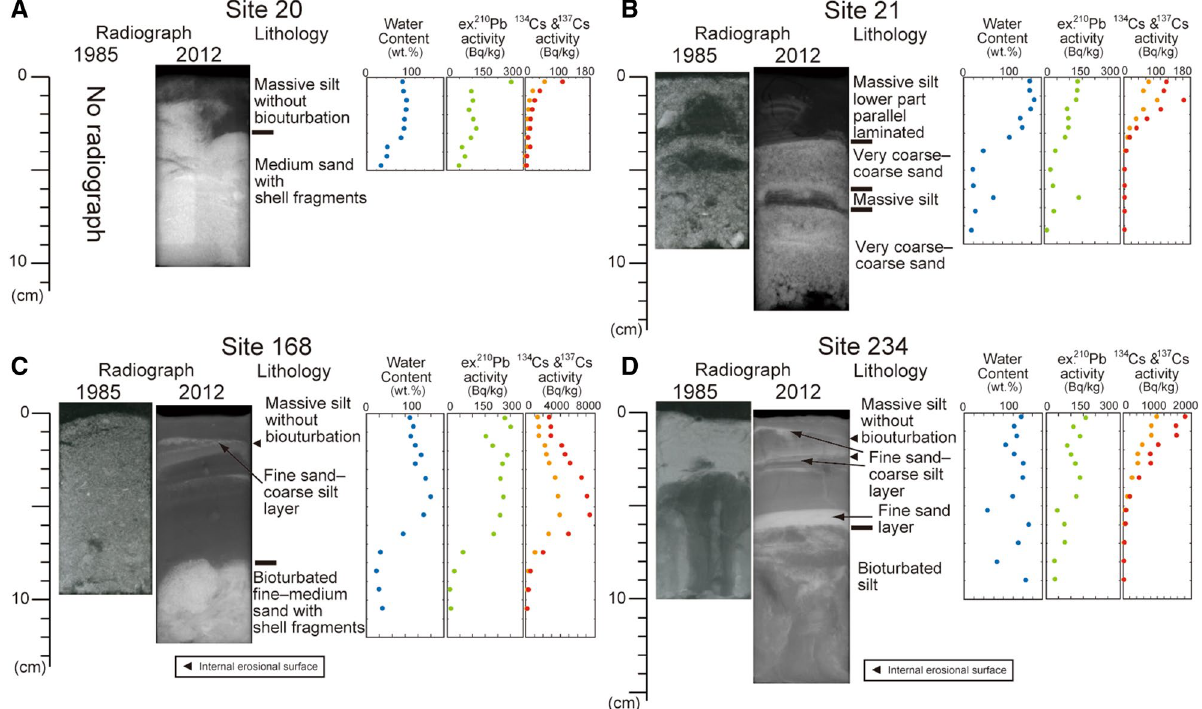
Figure 4. Comparison of sedimentary structures of the 1985 and 2012 sample, and description of 2012 subcore sample, and the profiles of water content (blue), excess 210 Pb (green), 134 Cs (orange), 137 Cs (red) activities at Sites 20 ( A ), 21 ( B ), west of the Oshika Peninsula, and at Sites 168 ( C ) and 234 ( D ), off Abukuma River the redeposited mud indicates that the benthos activity (burrowing) did not lead to the subsurface occurrence of 134 Cs. Although large ground shaking by the 2011 earthquake might have contributed to surface sediment resuspension 22 , the following tsunami-induced shear velocity resulted in large-scale erosion and the resuspension of shelf mud. Since the release of radionuclides to the atmosphere from the FDNPP started on March 12, 2011 and peaked on March 15, 1 and 4 days after the earthquake and tsunami, respectively, the particles must have been suspended in the shelf water for at least several days. Considering the occurrence of turbid bottom water a few weeks to months after earthquake 35,36 , the suspended shelf water condition might have been maintained for a few weeks or more. Therefore, the graded mud was most likely formed after the 2011 tsunami. Radioactive Cs found in high concentrations in the fine-grained portion of the surface sediments (Fig. 4). The same trend has been reported in the 2011 event deposits on the outer shelf of Sendai Bay 18,22 . As Cs can be strongly absorbed on mica-like clay minerals 37–39 , radioactive Cs might also absorb on the fine-grained clay minerals in the suspended shelf water. In addition, due to the higher concentration of total organic carbon in NISM and NWISM than that in CGS 24,40,41 , highly radioactive Cs might also absorb on the organic matters 42 in the suspended materials. The thickness of the graded mud without bioturbation ranges from a few cm to more than 17 cm (Fig. 3C). As the stable carbon isotopes and C/N ratios of the surface sediments before and after 2011 were similar 40,41 , the muddy sediments of NISM and NWISM were probably resuspended and redeposited on the Sendai inner shelf. The 134 Cs/ 137 Cs ratios (Supplementary Table S3) also suggest the remobilization of the young surface sediment. Using a half-life of 134 Cs (2.0 years) and 137 Cs (30.1 years), original 134 Cs/ 137 Cs ratios on April 1, 2011, when radiocesium was released from the FDNPP, were calculated as ~ 0.8 (0.67–0.98). However, since the initial 134 Cs/ 137 Cs ratio of the FDNPP derived radiocesium was ~ 1 30 , the additional 137 Cs amount in the observed ratios should be explained. The young surface sediments in NISM, NWISM and MSM were prob- ably resuspended and provided the extra 137 Cs in the event mud. The high and relatively constant activities of excess 210 Pb in the event mud (Fig. 4) also suggest the resuspension of the young surface sediment. In addition, the new mud covering west of the Oshika Peninsula at Sites 20 and 21 indicated that the resuspended muddy particles were deposited across the boundary between the previous NISM/NWISM and CGS. The volume of resuspended mud in NISM and MSM was calculated as > 20 × 10 6 m 3 from the redeposited mud thickness distri- bution (Fig. 3C). However, the volume may be larger than estimated, because part of the resuspended mud was moved offshore to the outer shelf and further to the slope area following the turbidity currents 17,18,21,22 . The sediment remobilization by the 2011 tsunami was also recognized in CGS based on the changes in the gravel contents and mode of sand fraction. The new deposition of massive sand over a sharp surface was observed at some sites (Fig. 3B and Supplementary Figs. S1E and F), while significant changes occurred along the 30 m water depth contour (Fig. 3C). The massive structure without burrows in the newly formed surface sand layers suggests that the layers are recent deposits and that there has been insufficient time for the macrobenthos to burrow into them. This area was also consistent with the area of high total energy of shear force [> 0.5 (N m −2 )